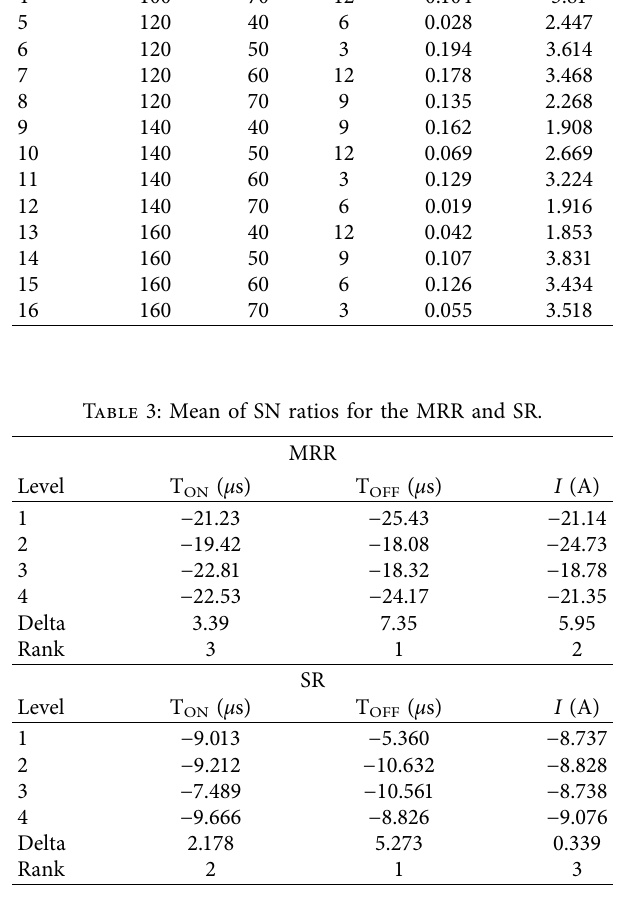
Table 2: L16 orthogonal array experimental results. 3